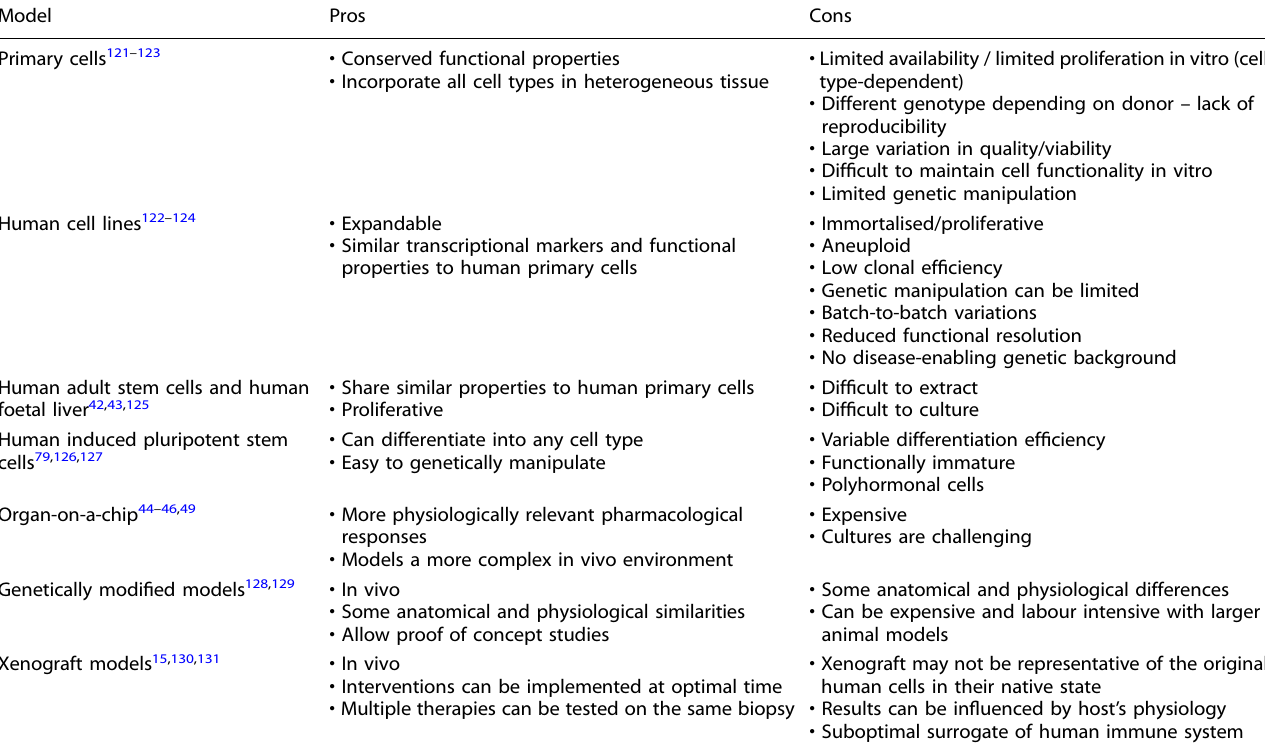
Table 2. Advantages and Pitfalls of Experimental Approaches in Disease Modelling.